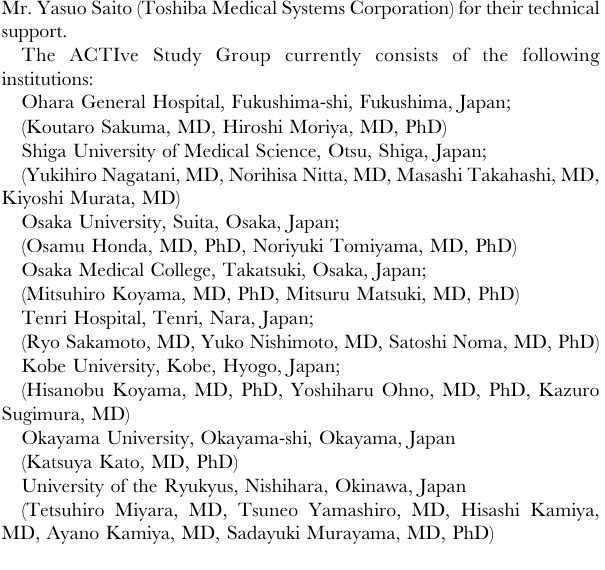
Figure S5 Axial plain chest CT images for diffuse lung disease (73-year-old female weighing 62 kg). Images are arranged as in Figure E1. Multiple GGO and reticular shadows, accompanying slight bronchiectasis, were observed in the right lower lobe.